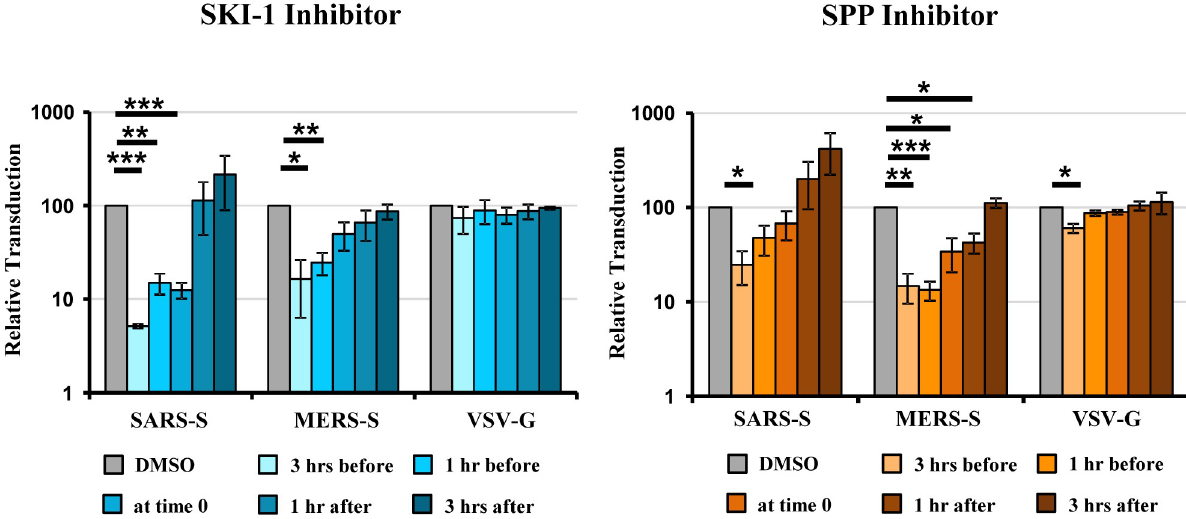
Fig 3. SPP and SKI-1 inhibitors block SARS-S- and MERS-S-driven entry. Rhabdoviral particles pseudotyped with the indicated viral glycoproteins were used for transduction of 293T cells treated with the indicated inhibitors at the indicated time points. Transduction efficiency was analyzed